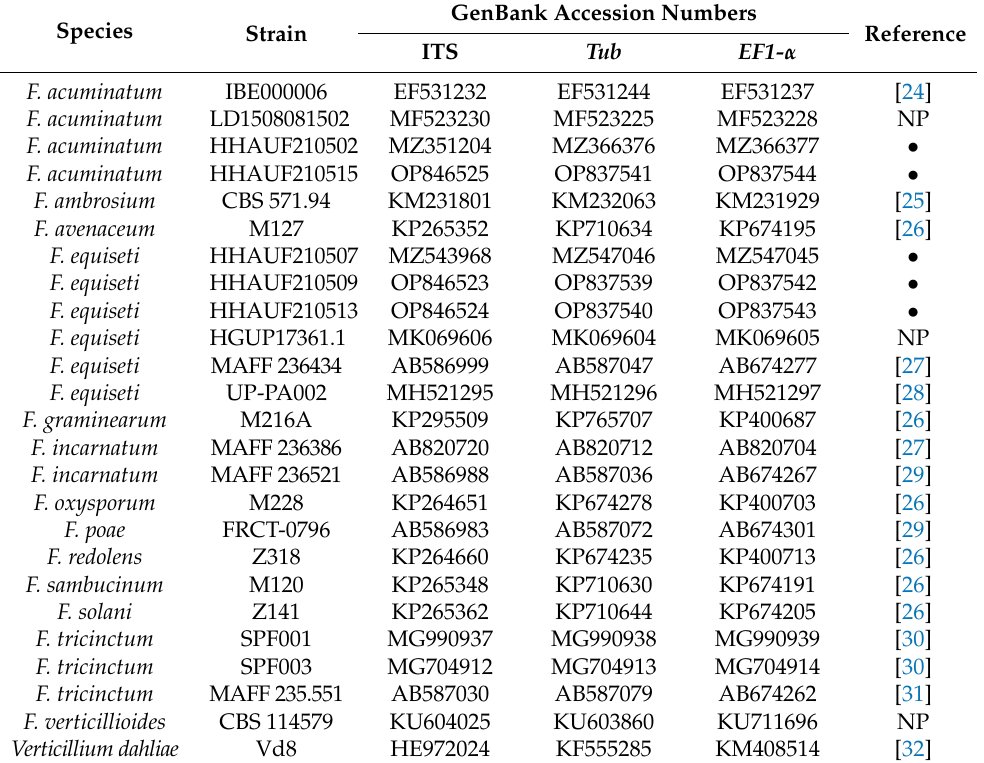
Table 1. Isolates used for phylogenetic analyses in the study and their GenBank accession numbers. GenBank Accession Species Strain